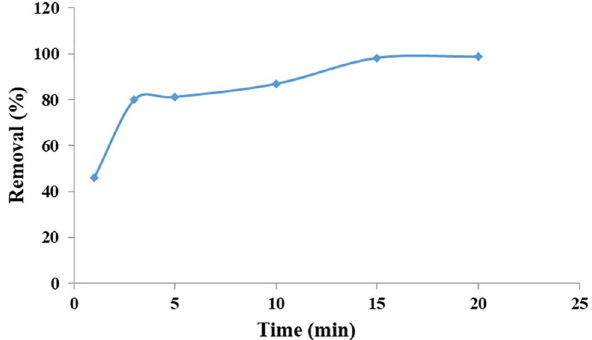
Figure 16. Effect of time.